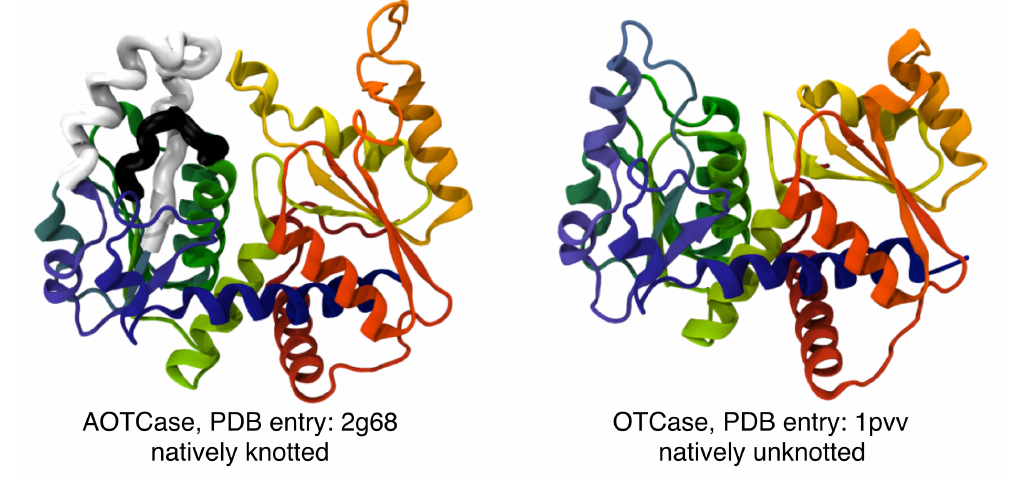
Figure 6. Knotted and unknotted carbamoyltransferases. Cartoon representation of AOTCase (on the left ), which is natively-knotted in a right- handed trefoil knot, and the unknotted OTCase (on the right ). The two proteins have a noticeably-good